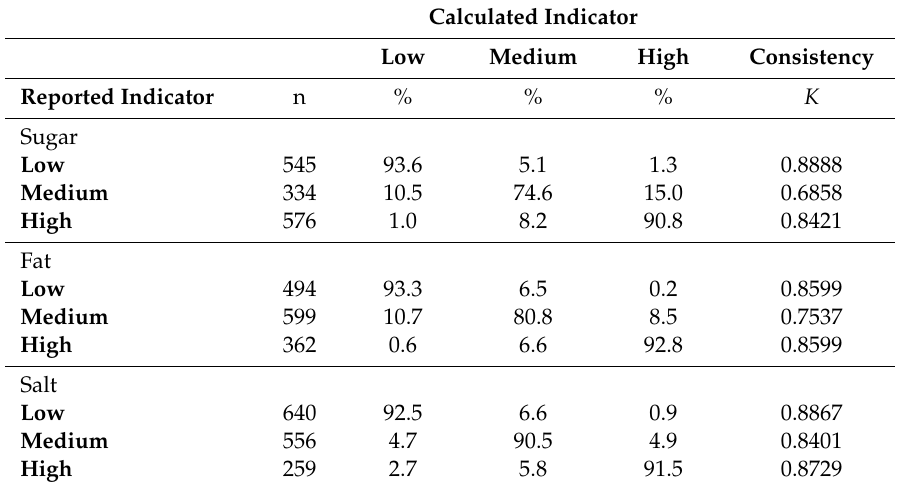
K: kappa coe ffi cient, values above 0.8 indicate good